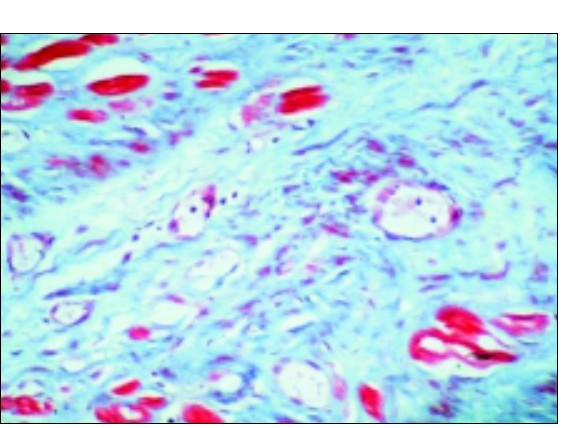
Fig. 5 - Corte histológico do VE, mostrando vasos neoformados de pequeno calibre (setas), em meio à trave de fibrose intersticial (tricrômico de Masson, aumento original X 63).